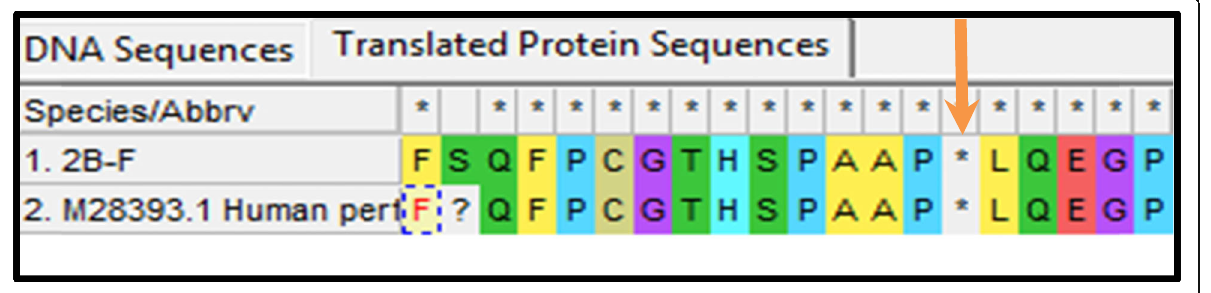
Fig. 3 Protein translation shows resultant stop codon using MEGA